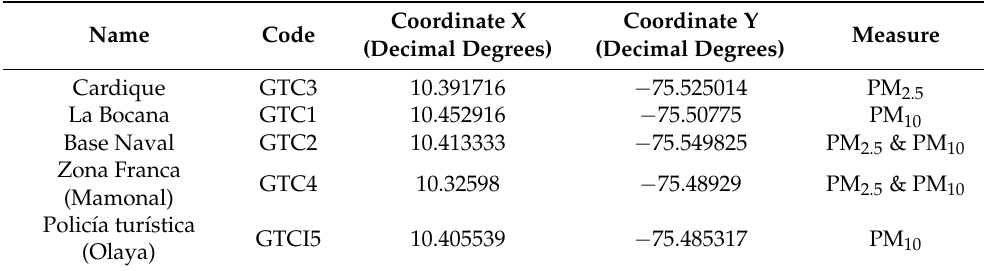
Table 2. List of measurement station locations and measured particulate